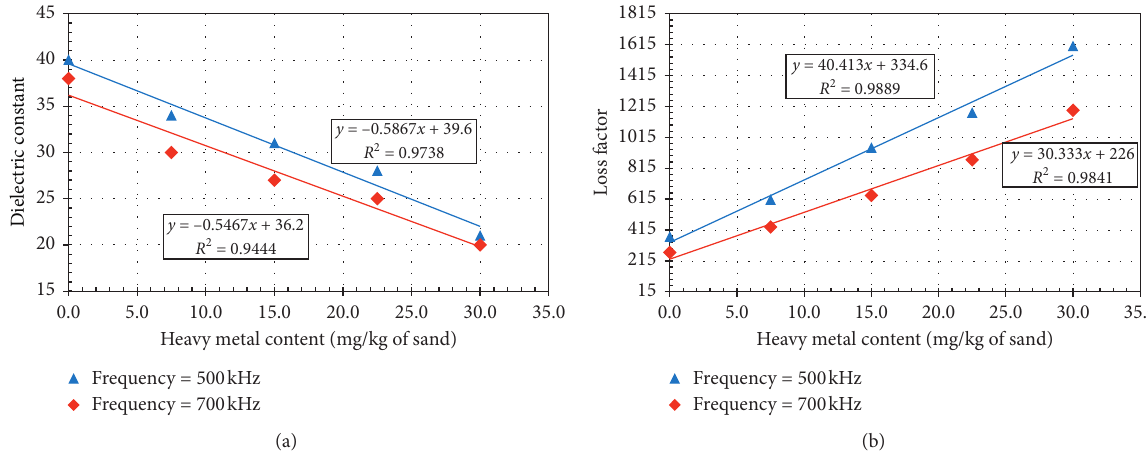
Figure 10: Regression analysis of complex permittivity and Zn content. (a) Dielectric constant versus Zn content. (b) Loss factor versus Zn content.